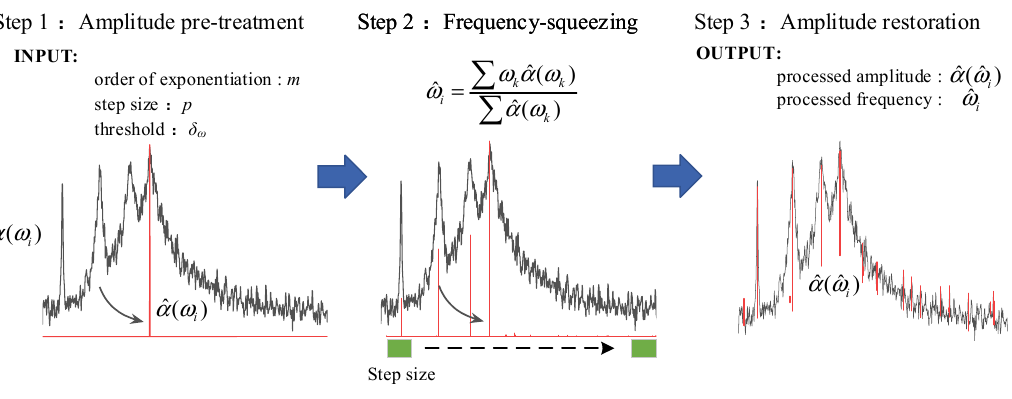
Figure 2. A schematic diagram of FSP.